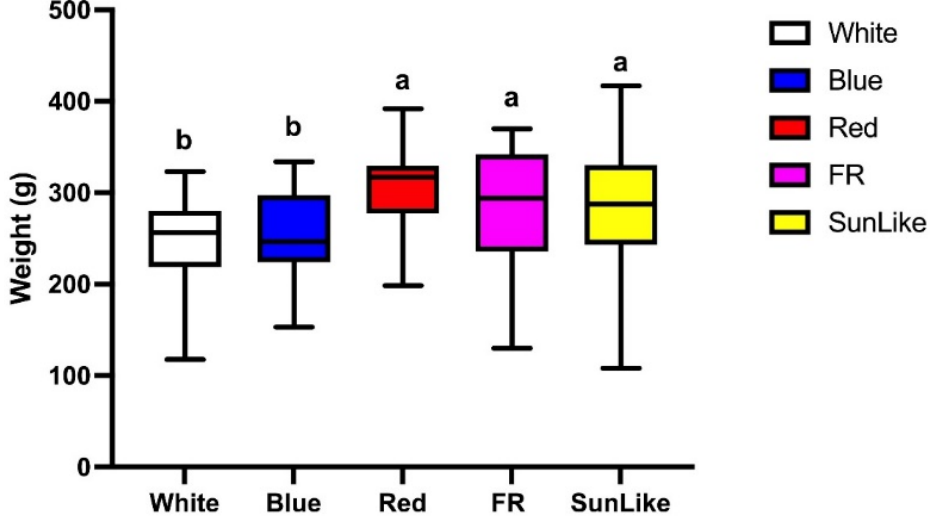
Figure 3. Effect of different light quality light treatments in the range of 1–10 μ mol.m − 2 .s − 1 on the yield of fruiting bodies of P. eryngii .